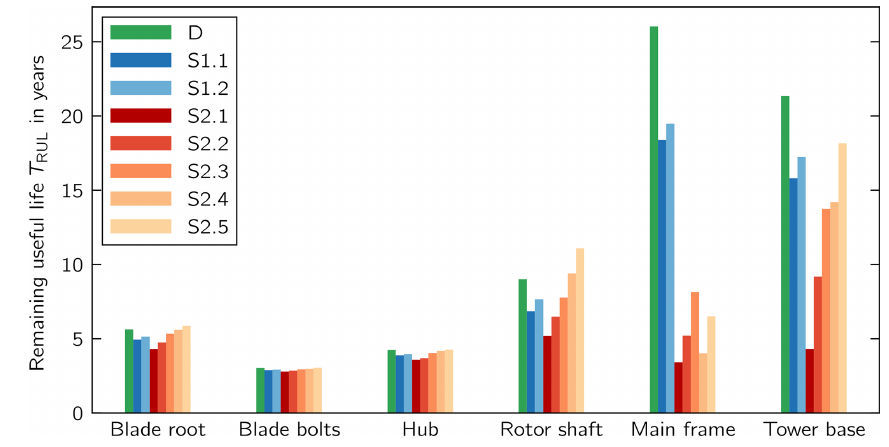
Figure 6. Remaining useful life (RUL) of components in design (D) situation and imbalance scenarios (S).